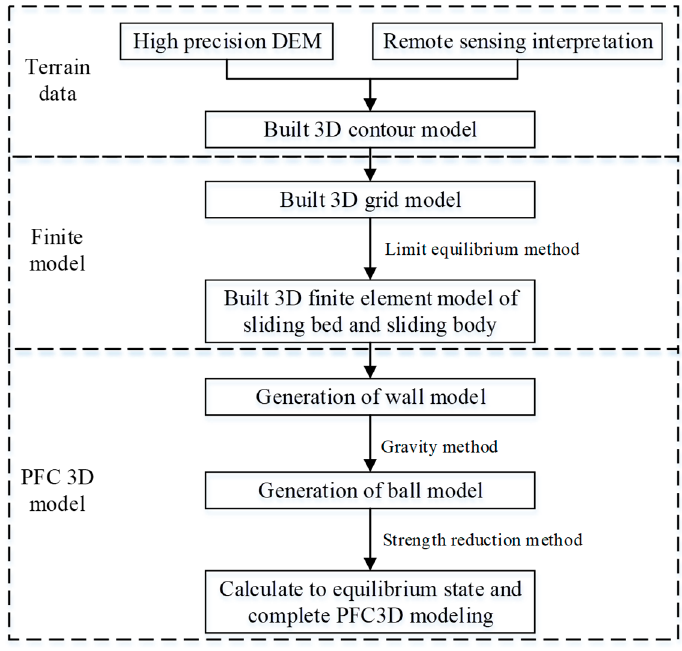
Figure 6. Flowchart of particle flow code 3D (PFC3D) modeling.